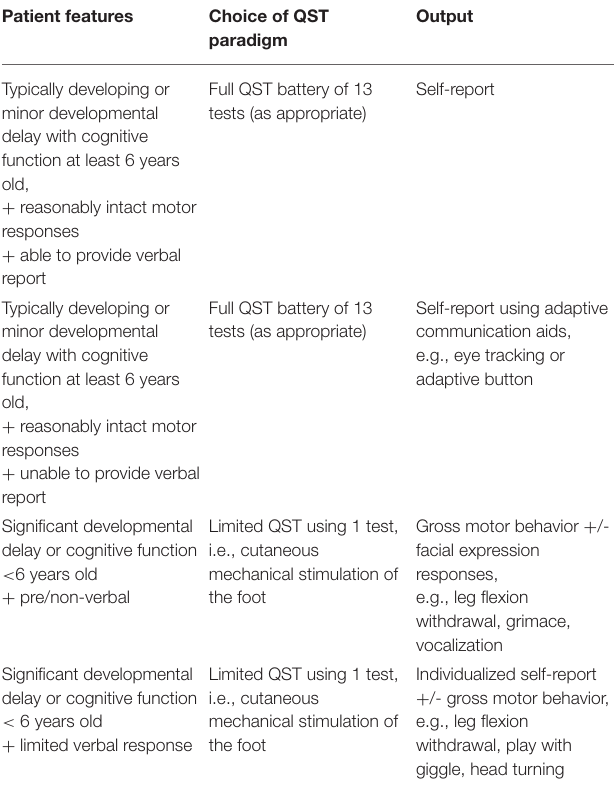
TABLE 1 | Summary of general approaches for quantitative sensory testing in diverse